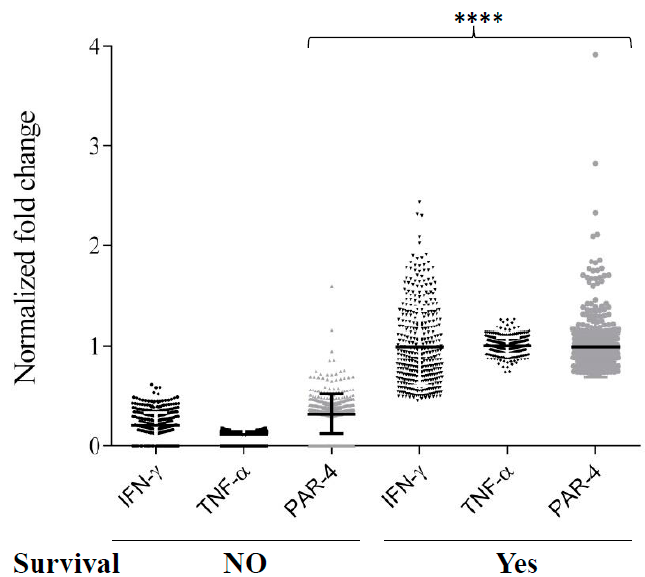
Figure 7. Expression levels of IFN- γ , TNF- α , and PAR-4 in neuroblastoma patients and their survival. Normalized gene expression of IFN- γ , TNF- α , and PAR-4 were analyzed in patients with their survival outcome. Dunn’s Multiples comparison was used to determine significant differences between groups (**** p < 0.0001).